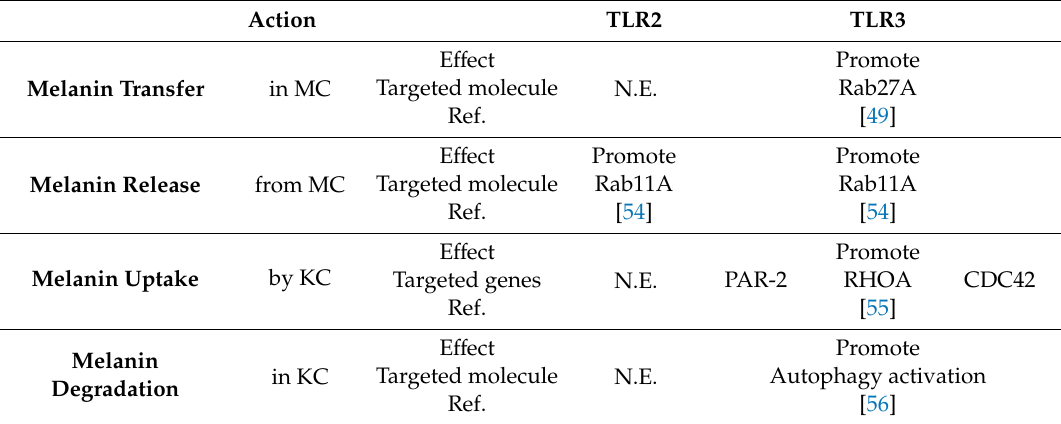
CpG-DNA (cid:88) (cid:88) Promote TYR, PMEL